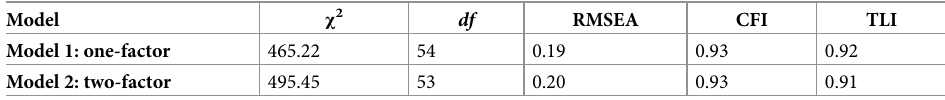
Table 1. Goodness-of-fit indices of the two models of enthusiasm for teaching. Model